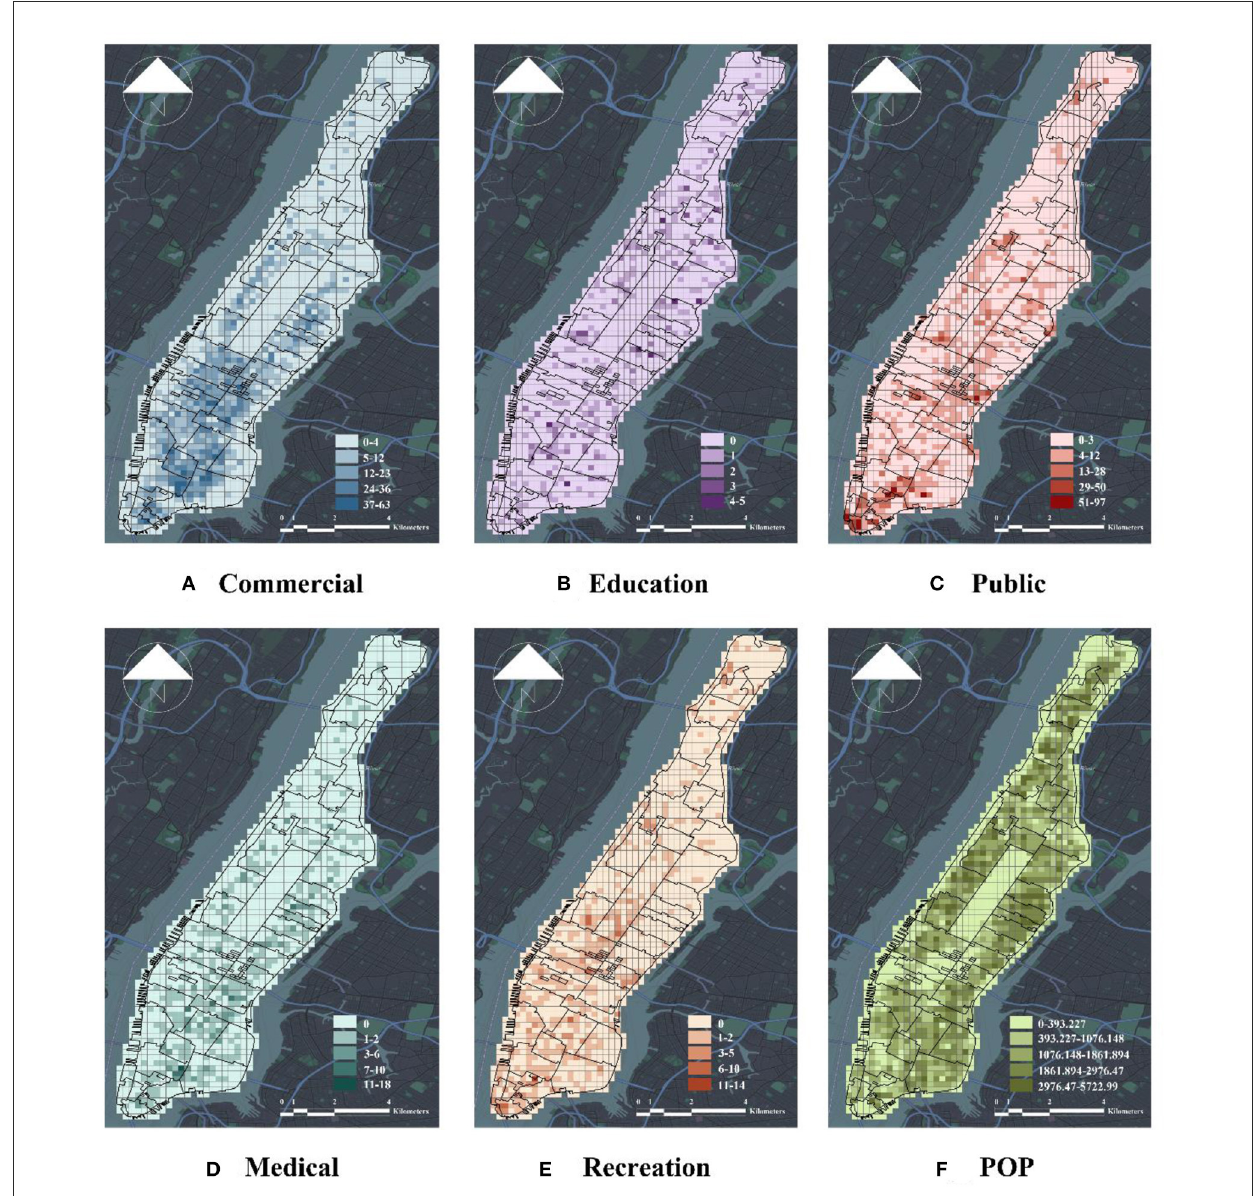
FIGURE4 Visualization of macro-scale factors of urban built environment. (A) Commercial, (B) education, (C) public, (D) medical, (E) recreation, and (F)